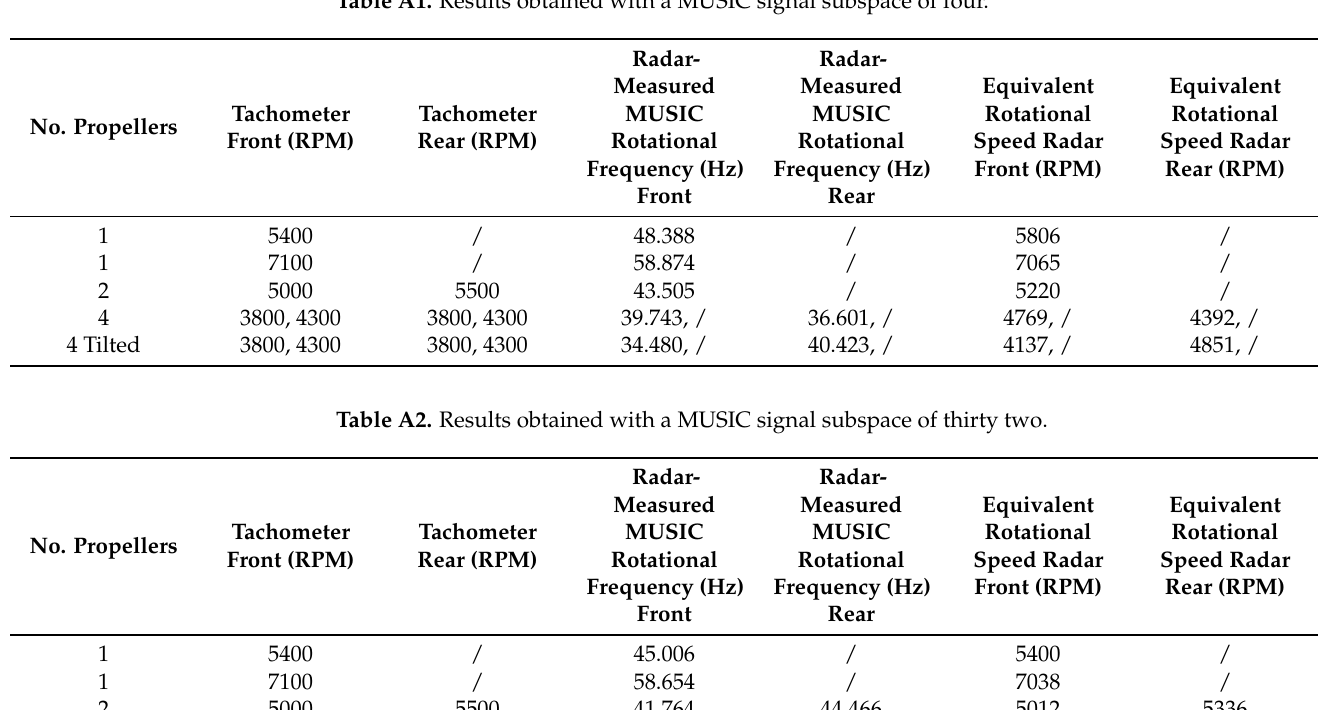
Table A1. Results obtained with a MUSIC signal subspace of four.